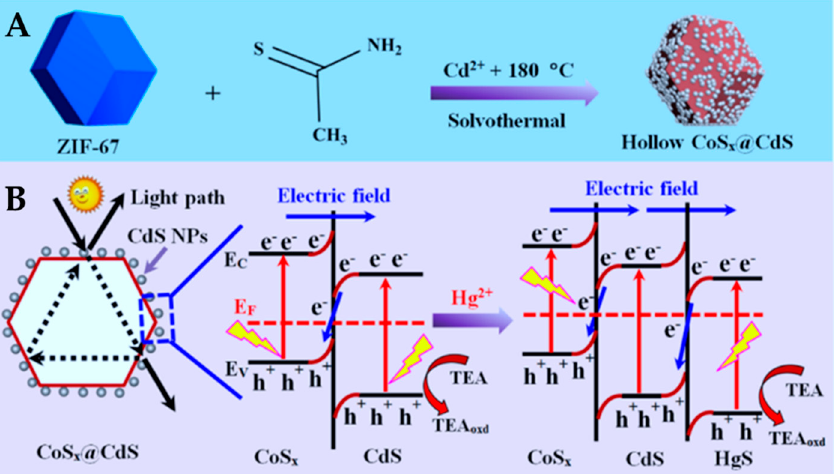
Figure 10. Scheme of ( A ) the synthetic route of hollow CoSx polyhedrons and CoSx@CdS composites; ( B ) Z scheme charge migration mechanism CoSx@CdS composites and double CoSx@CdS/HgS heterojunction under the visible − light illumination [138].